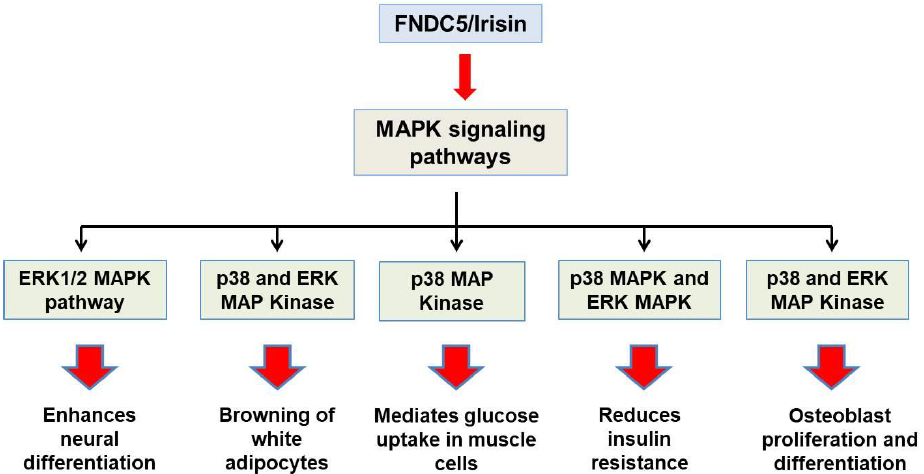
Figure 2. Schematic representation of physiological roles of Fndc5/irisin through MAPK signaling pathways.